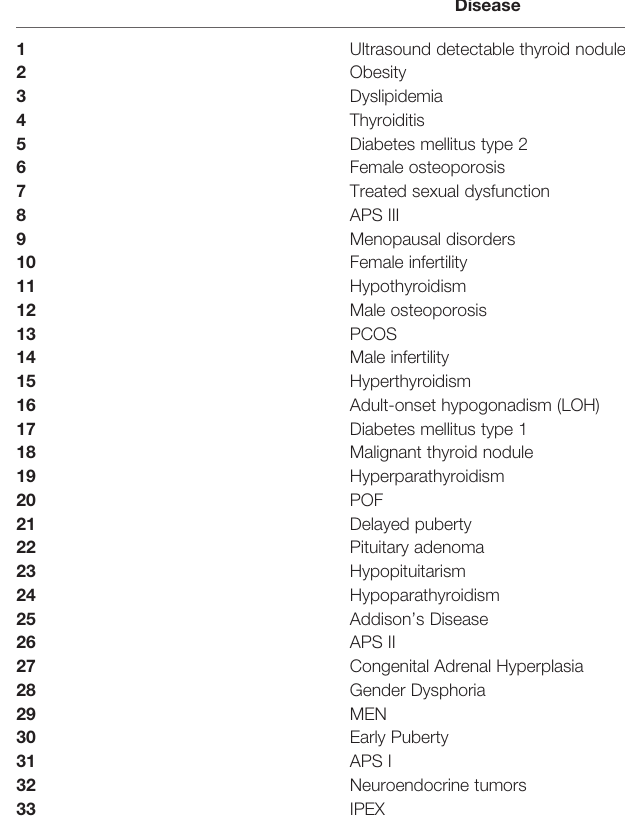
TABLE 2 | List of major endocrine diseases (in decreasing order of